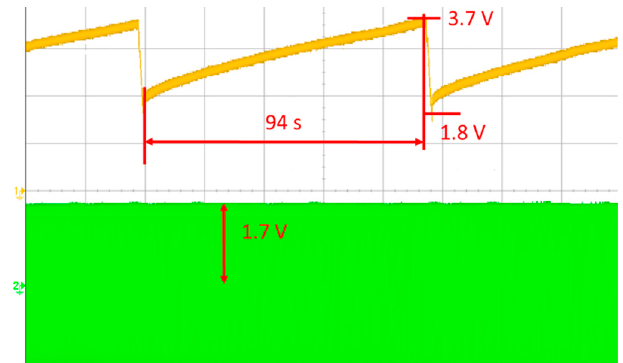
Figure 11. Operation of power management for battery-less system.